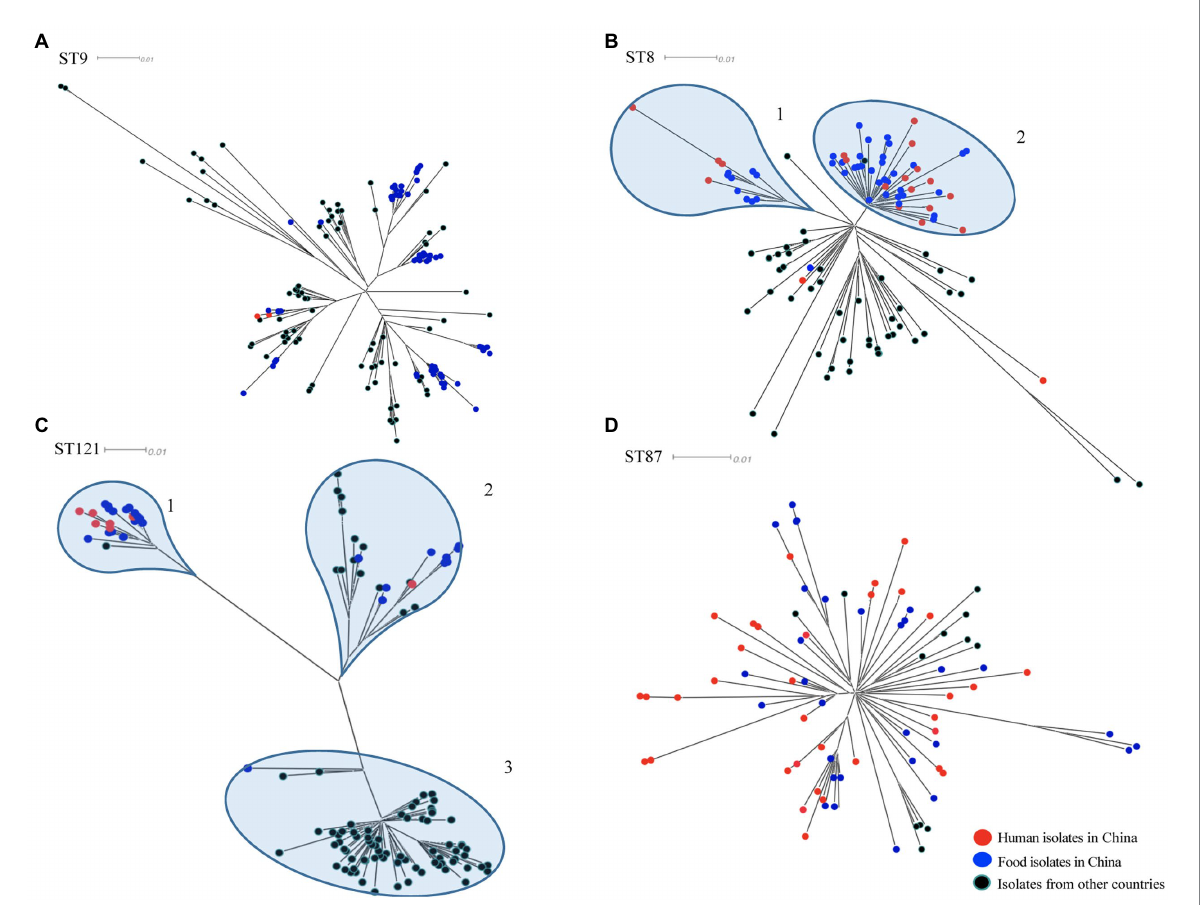
FIGURE 3 The core-SNP phylogenetic tree of prevalent subtypes of L. monocytogenes in China in the context of global isolates. The trees were visualized using SplitsTree 5. (A) Maximum likelihood phylogeny of 156 L. monocytogenes ST9 genomes based on 2,269 core-SNPs, annotation of SLCC2479 was used as reference. (B) Maximum likelihood phylogeny of 115 L. monocytogenes ST8 genomes based on 1,327 core-SNPs, annotation of ICDC_LM2 was used as reference. (C) Maximum likelihood phylogeny of 132 L. monocytogenes ST121 genomes based on 2,236 core-SNPs, annotation of ICDC_LM135 was used as reference. (D) Maximum likelihood phylogeny of 82 L. monocytogenes ST87 genomes based on 1,058 core-SNPs, annotation of ICDC_LM188 was used as reference. Human isolates in China are represented by red circles, food isolates in China are represented by blue circles, isolates from other countries are represented by black circles. Light blue circles represent